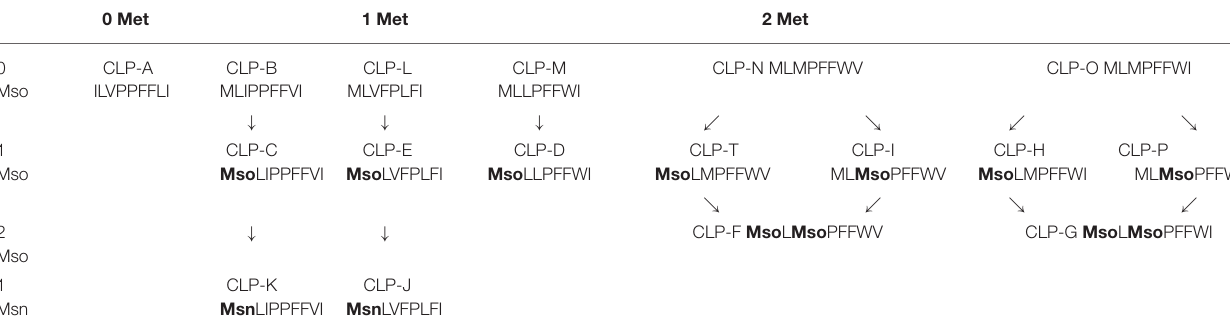
TABLE 3 | Oxidative pathways of CLPs [according to Lao et al. (17)].